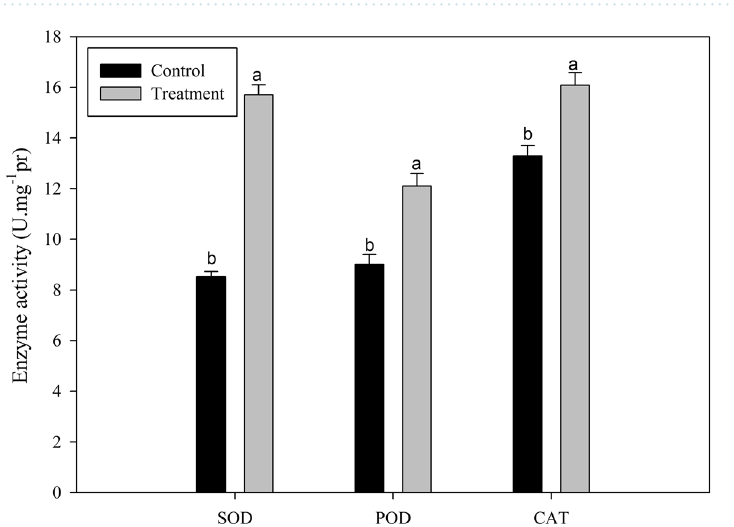
Figure 6. Changes in related enzyme activities. Activities of the SOD, POD and CAT enzymes in pepper leaves (Control group and Treatment group) were measured on 21st day after Chlorella extracts treatment. Control: no Chlorella extracts treatment; Treatment: plants were treated by Chlorella extracts; SAS analysis at 5% is shown in lowercase letters to indicate significant differences. Vertical bars in the figures represent ± SD of five independent biological